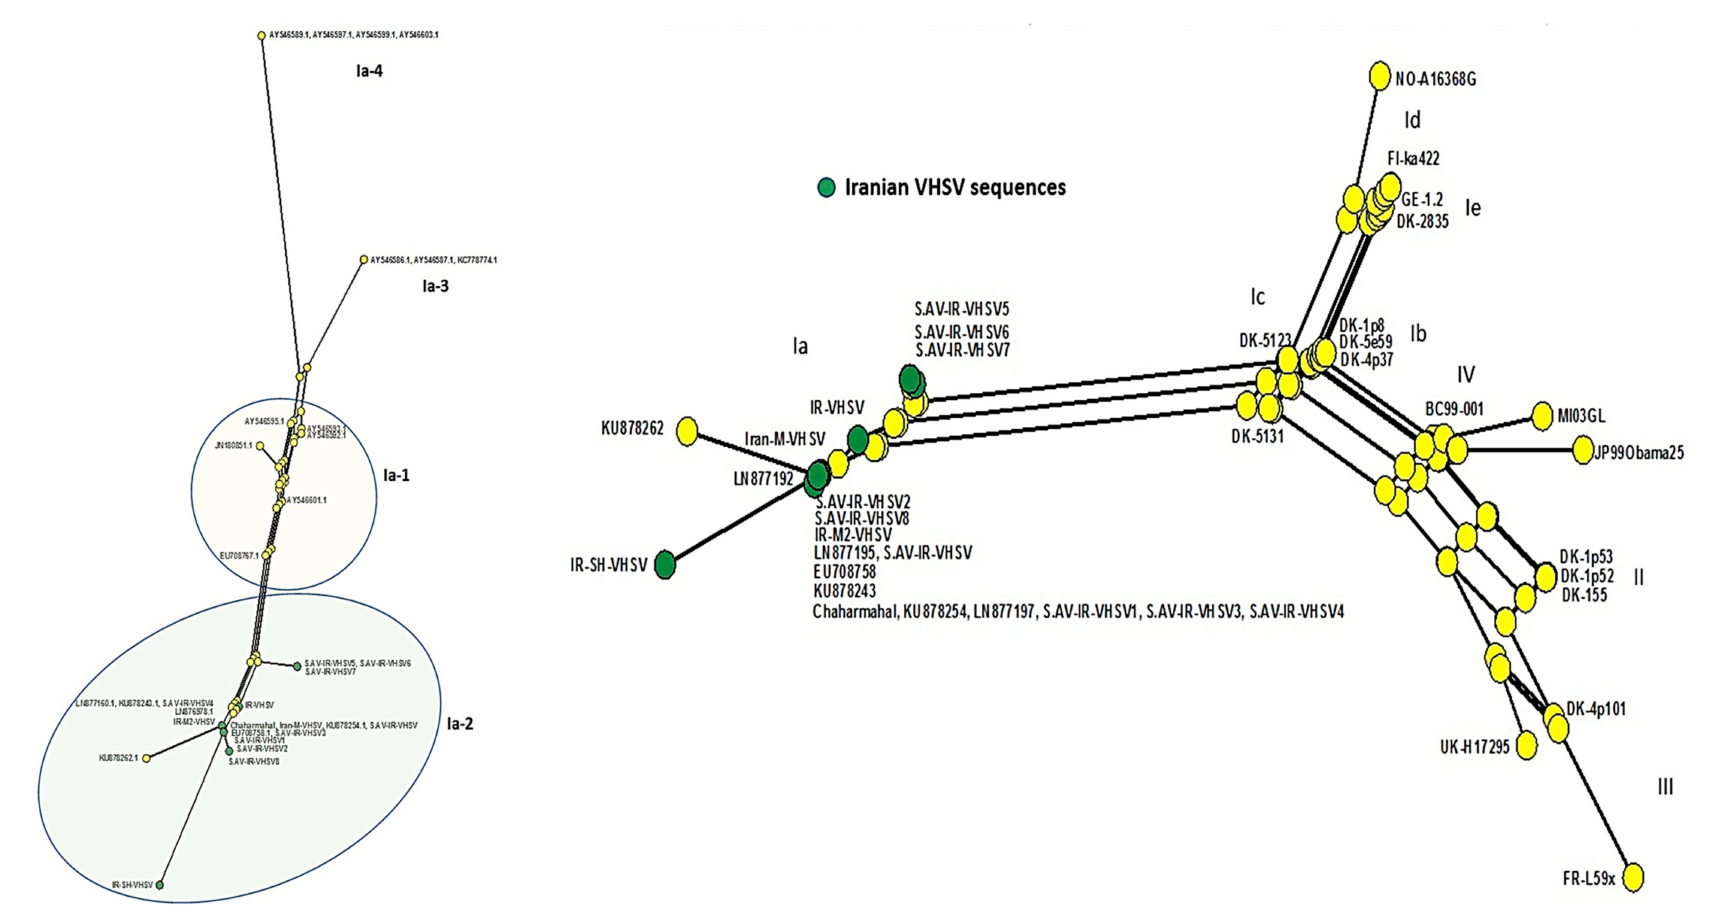
Figure 3. Neighbor network of non-homologous amino acids of VHSV glycoprotein fragment (513 bp). Left panel genotype Ia sequences only. Right panel all genotype sequences as indicated in Figure 2. Green circles indicate Iranian